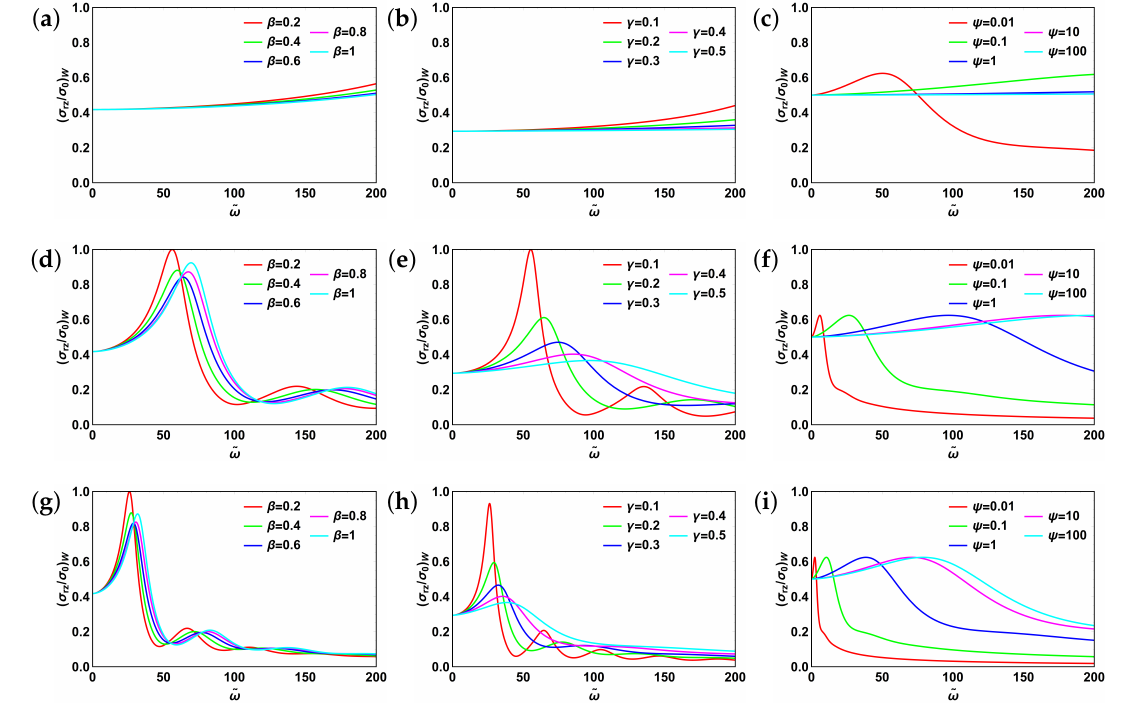
Figure 10. Shear stress at the pipe wall for fractional Poynting-Thomson model: ( a ) ˜ a = 0.01, α = γ